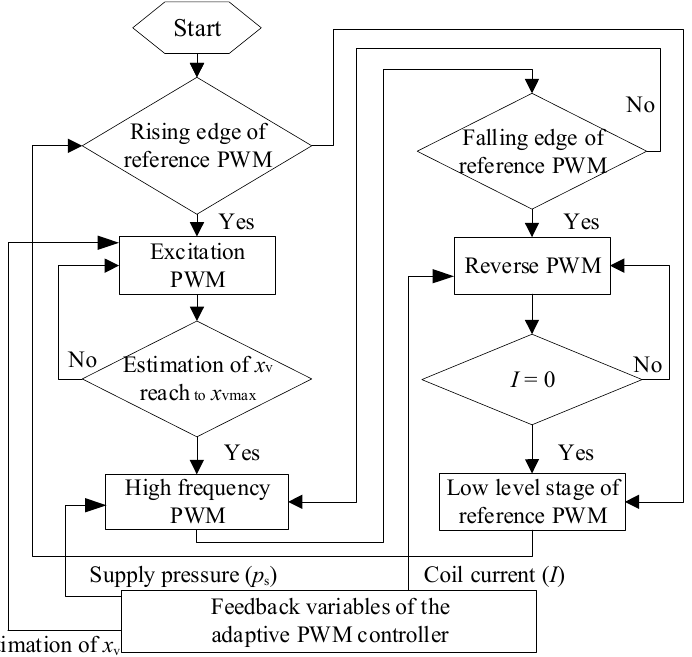
Figure 11. Flow chart of adaptive PWM control.